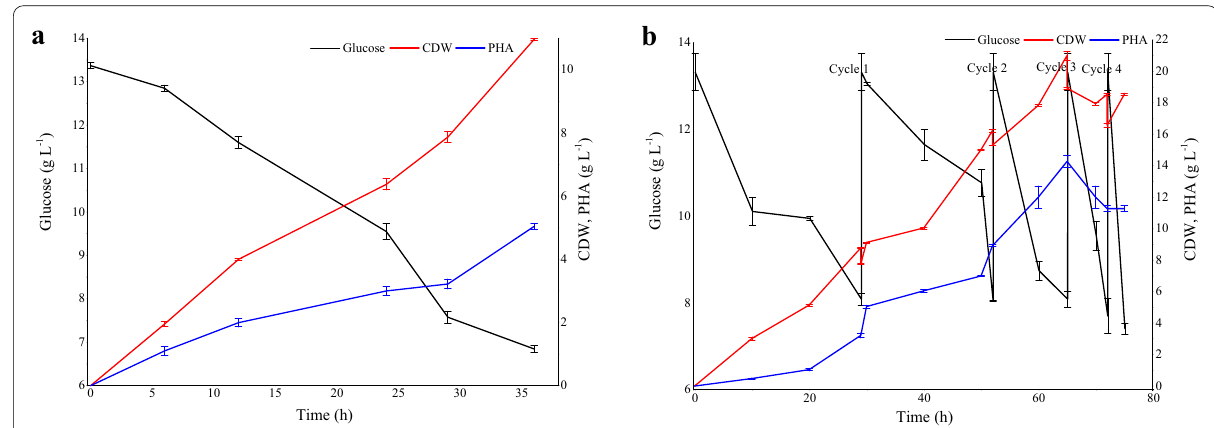
Fig. 3 Kinetics of cell proliferation, carbon consumption and PHA production by B. thuringiensis in batch fermentation ( a ) and cyclic fed-batch fermentation ( b